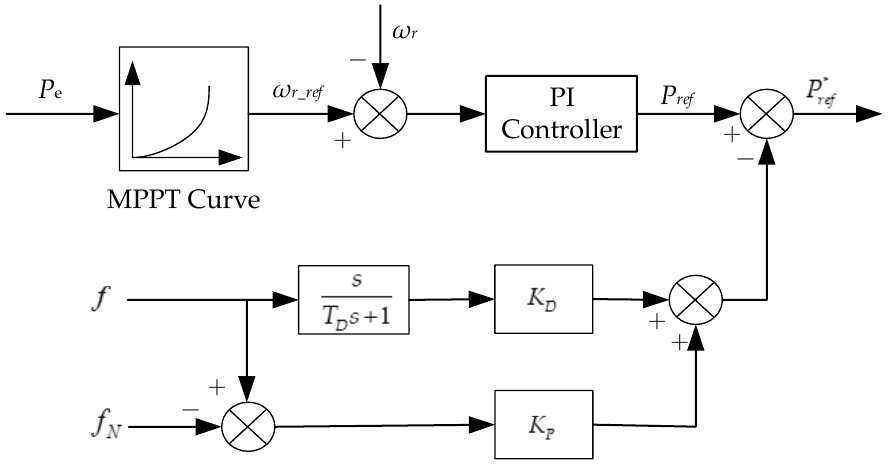
Figure 1. Active power control strategy of DFIG-based WTs under